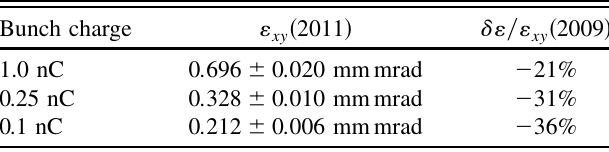
TABLE II. Minimum emittance measured in 2011 " xy ð 2011 Þ and corresponding emittance reduction since 2009 (cid:5)" ¼ ð 2011 Þ (cid:2) " ð 2009 Þ " xy xy